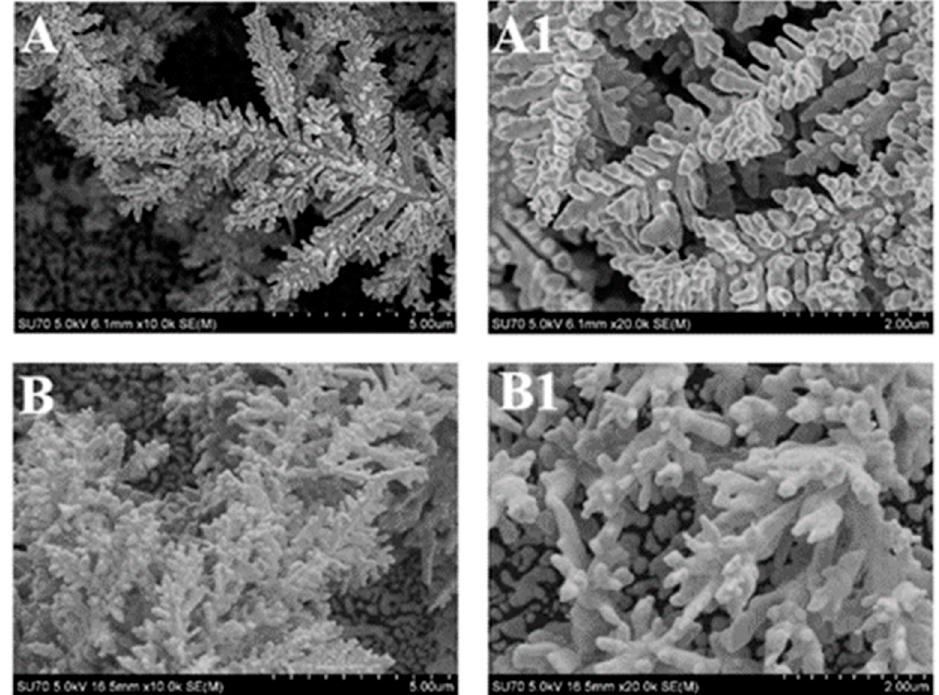
Figure 6. FE-SEM images of DGNs on the electrode surface obtained after electrochemical deposi- tion using CPA ( A , A1 ) and DPV methods ( B , B1 ). Synthesis of DGNs was performed in the solution of 6 mmol L − 1 HAuCl 4 with 0.1 mol L − 1 KNO 3 .